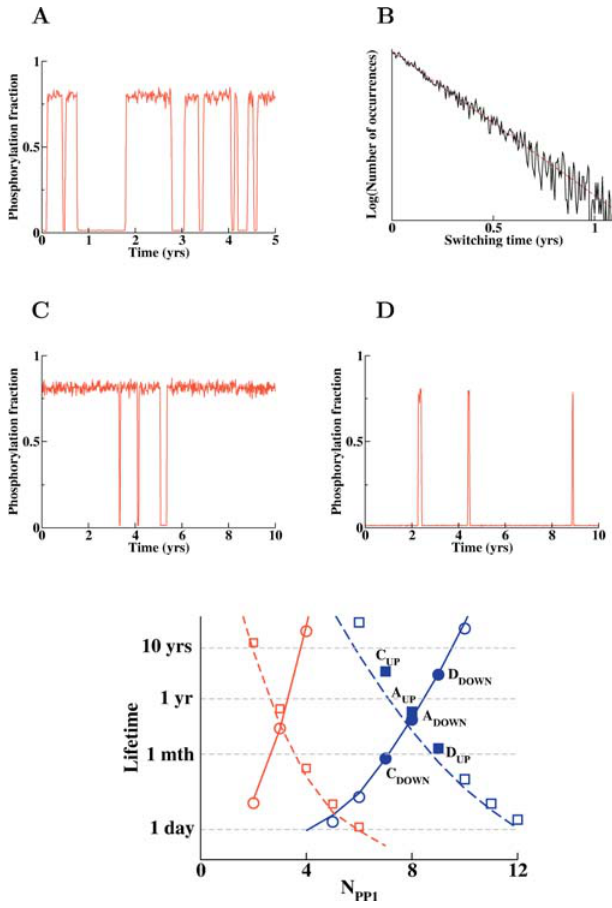
Figure 2. Switch Stability Is a Trade-Off between Lifetimes of UP and DOWN States (A) Spontaneous switching between UP and DOWN states in a system with eight CaMKII holoenzymes. (B) The distribution of lifetimes between switching events is exponential, as demonstrated by the straight line fit for lifetimes of the UP state on a semi-logarithmic scale. (C and D) Removing one PP1 enzyme (seven instead of eight) (C) leads to a longer lifetime for the UP state but shorter lifetime for the DOWN state; whereas adding one PP1 enzyme (nine instead of eight) (D) yields the opposite effect. (E) Dependence of average lifetimes of the UP state (squares) and DOWN state (circles) as a function of the number of PP1 enzymes (with eight CaMKII holoenzymes). Filled blue symbols correspond to data points from (A), (C), and (D). Lines are approximate, analytic results (based on Materials and Methods and [51]). The optimal lifetime of the switch is defined by the intersection point of the two curves, at which the lifetimes of the UP and DOWN states are equal. Blue indicates reference parameters. Red indicates k 1 = 0.75 s (cid:1) 1 , one- half of the standard value. The lifetime does depend on kinetic parameters, but maximum stability is approximately the same, albeit with a different number of PP1 molecules. PLoS Biology |